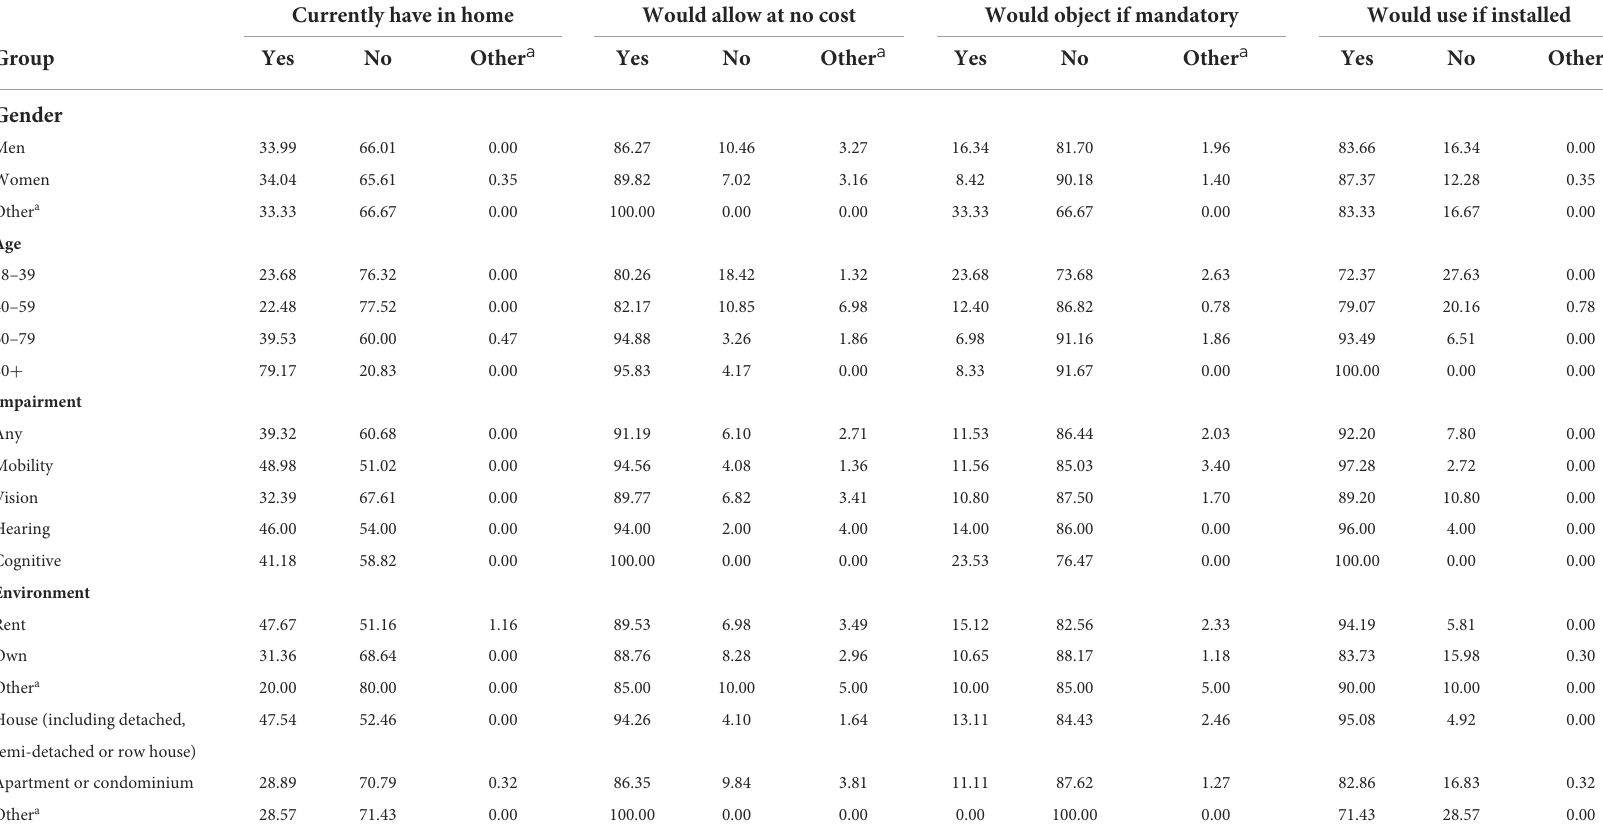
TABLE 2 Frequency of question responses (%), by demographic factors, disability status, and living